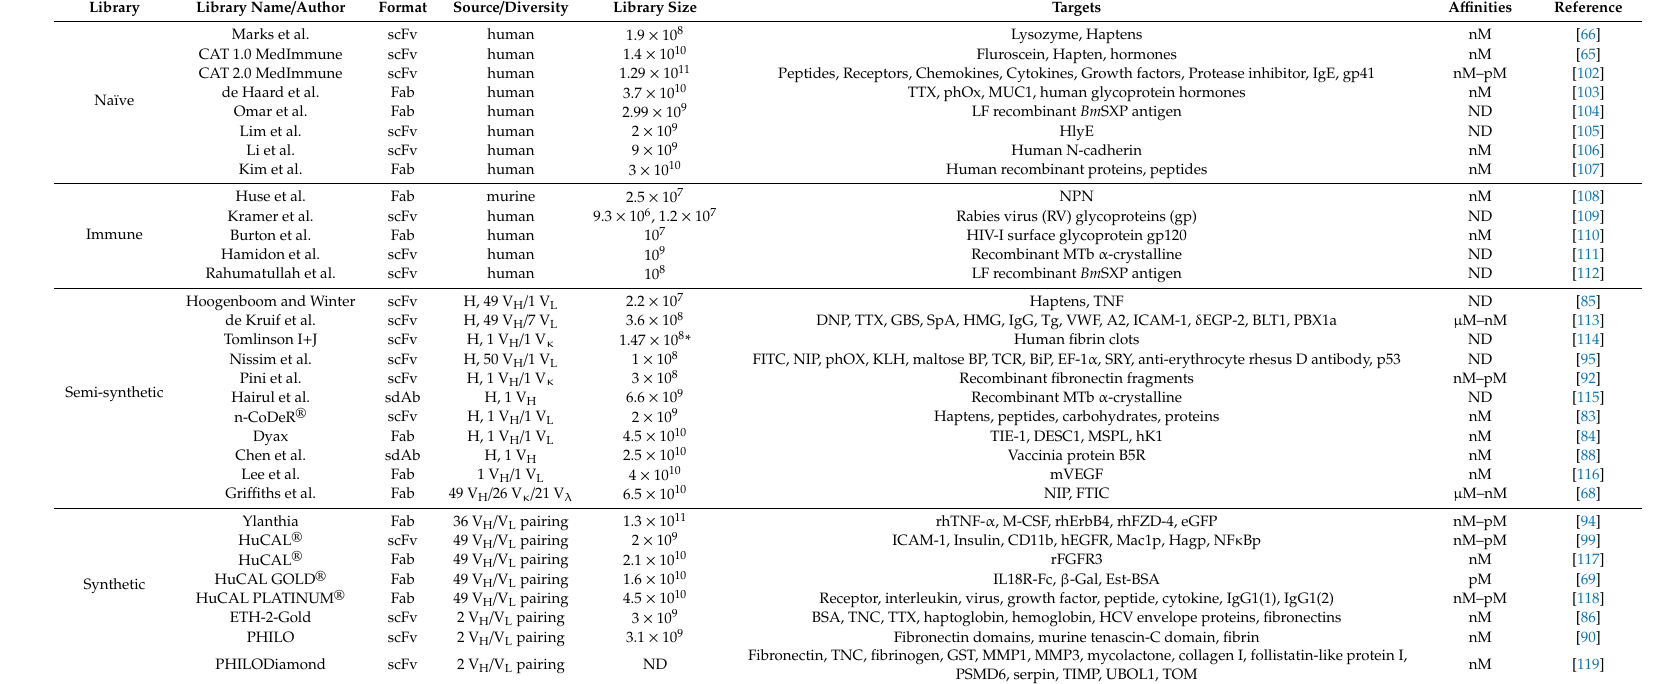
scFv: Single chain variable fragment; Fab: Antigen-binding fragment; sdAb: Single domain antibody; H: Human; ND: Not determined; NPN: KLH coupled p-nitrophenyl phosphonamidate antigen I; TNF: Tumour necrosis factor; DNP: Dinitrophenyl; TTX: Tetanus toxoid; GBS: Group B streptococcal type III capsular polysaccharide; SpA: Human surfactant protein; HMG: HMG box domain of T-cell specific transcription factor; Tg: thyroglobulin; VWF: Von Willebrand factor; A2: VW fragment 2; ICAM-1: intracellular adhesion molecule I; δ EGP-2: deletion mutant of the epithelial glycoprotein EGP-2; BLT-1: Brain, lung T-cell specific DNA binding protein; PBX1a: Pre-B homebox 1a; FITC: Fluorescein isothiocyanate, NIP: 4-hydroxy-5-iodo-3-nitrophenylacetyl; phOx: 2-phenyl-5-oxazolone; KLH: Haemocyanin from keyhole limpet; maltose BP: Maltose binding protein; TCR: Soluble chimeric murine T-cell receptor; BiP: Recombinant rat immunoglobulin binding protein; EF-1 α : Human elongation factor 1 α ; SRY: Human sex-determining region Y protein; p53: Human tumour suppressor protein p53; MUC1: Breast cancer associated antigen; HIV-I: Human immunodeficiency type I; LF: Lymphatic filariasis; MTb: Mycobacterium tuberculosis ; HlyE: Salmonella typhi hemolysin E; mVEGF: Murine vascular endothelial growth factor; TIE-1: Tyrosine kinase with Immunoglobulin like And EGF like domains 1; DESC1: Endotheliase 1; MSPL: Endotheliase 2; hK1: Human tissue kallikrein; rhTNF- α : Recombinant human tumour necrosis factor alpha, M-CSF: Macrophage colony-stimulating factor, rhErbB4: Recombinant human tyrosine kinase receptor 4; rhFZD-4: Recombinant human frizzled class receptor 4; eGFP: Enhanced green fluorescent protein; CD11b: Type 1 transmembrane glycoprotein (Mac-1); hEGFR: Human epidermal growth factor receptor; Mac1p: Mac-1 peptide; Hagp: Hag peptide; NF κ Bp: NF κ B peptide; rFGFR3: Recombinant human fibroblast growth receptor 3; IL18R-Fc: Fc- conjugated interleukin-18 receptor alpha; β -Gal: β -galactosidase; Est-BSA: β -estradiol coupled to bovine serum albumin; TNC: C-domain of tenascin-C; HCV: Hepatitis C Virus; GST: Glutathione-S-transferase; MMP1 / 3: Human matrix metalloproteinase 1 / 3, PSMD6: Proteosome 265; TIMP: Tissue inhibitor of metalloproteinase; UBQL1: Ubiquilin I; TOM: Translocase of the outer membrane. *Obtained from manufacturer’s